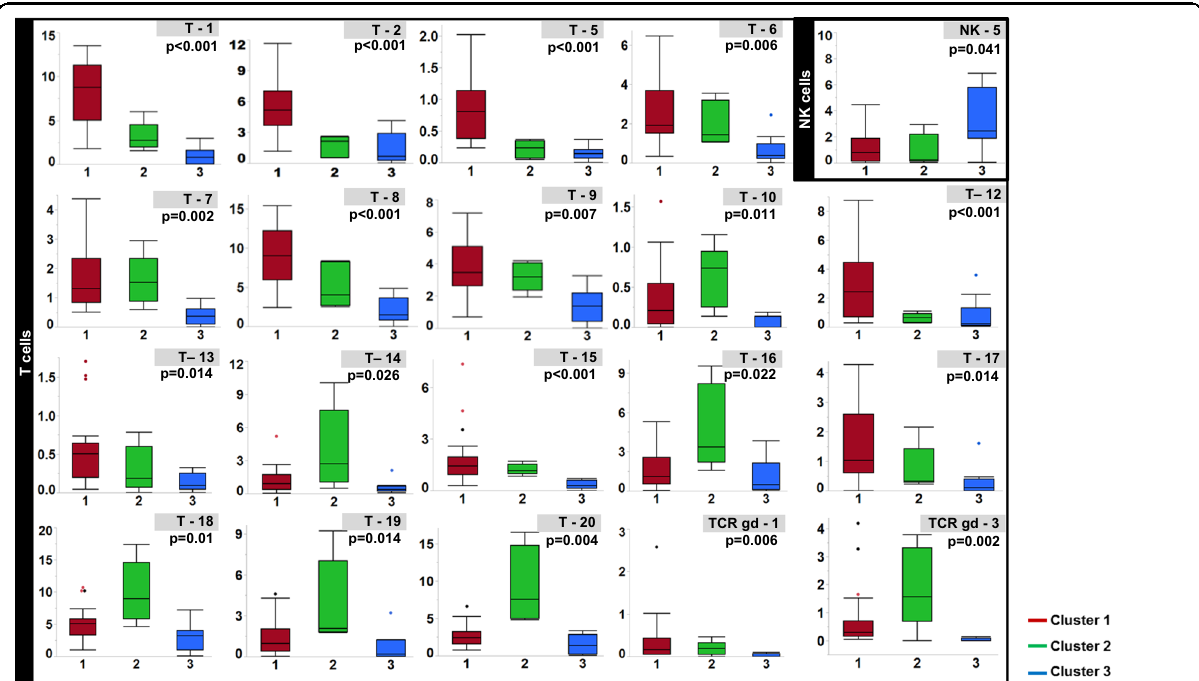
Fig. 3 Box plots showing the differential abundance of immune subsets. The frequency of immune cell subsets within each iTME cluster are shown as the percentage of total CD45 + cells. For clarity, only subsets that were signi fi cantly different between (false discovery rate corrected p value of < 0.05) the three clusters are